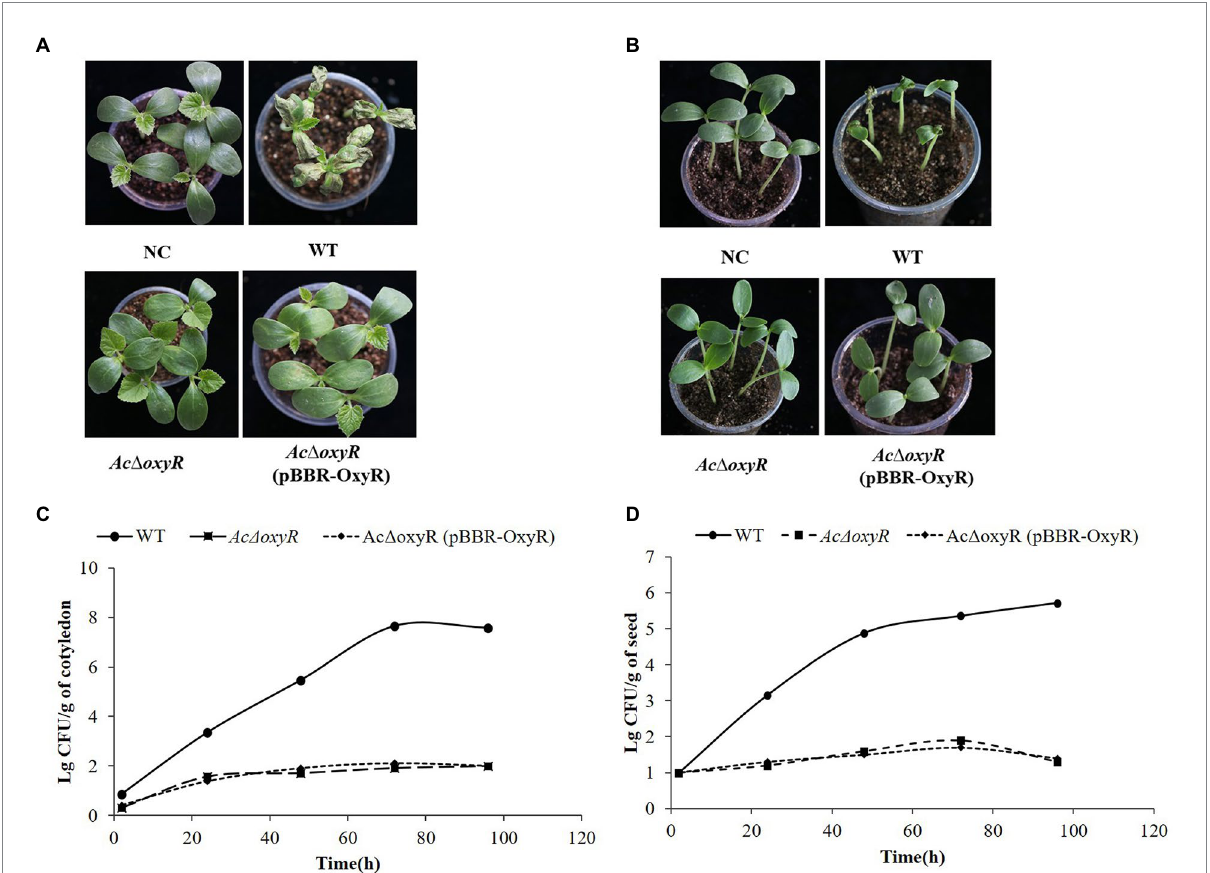
FIGURE 6 Role of oxyR in Acidovorax citrulli virulence and bacterial growth on melon. (A) Melon seedling cotyledons inoculated by injection with A. citrulli wild-type (WT), Ac Δ oxyR , and Ac Δ oxyR (pBBR- OxyR; ~1 × 10 3 CFU/ml) strains, and double-distilled H 2 O (ddH 2 O) as a negative control (NC). Seedlings were observed for bacterial fruit blotch symptoms at 5 days post-inoculation(dpi). (B) Melon seeds were inoculated by soaking in bacterial cell suspensions (~1 × 10 6 CFU/ml) of A. citrulli WT, Ac Δ oxyR , and Ac Δ oxyR (pBBR-OxyR). BFB symptoms were observed 7 days after planting. (C) Bacterial suspensions (~1 × 10 3 CFU/ml) of each strain were injected into cotyledons of melon seedlings and populations were quantified at 0, 24, 48, 72, and 96 h postinoculation. (D) Melon seed were inoculated with A. citrulli strains (~1 × 10 3 CFU/ml) planted under conditions conducive for bacterial fruit blotch development and bacterial populations on emerging seedling tissues were quantified at 0, 24, 48, 72, and 96 h after planting. Experiments were repeated three times with similar